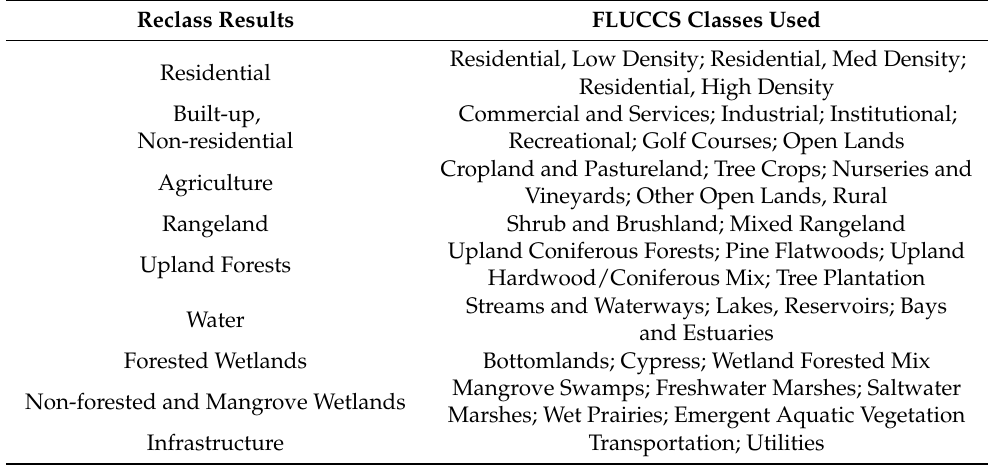
Table 6. Class equivalencies between original SWFWMD classes and new land use/land cover classes after applying AOV and post-hoc